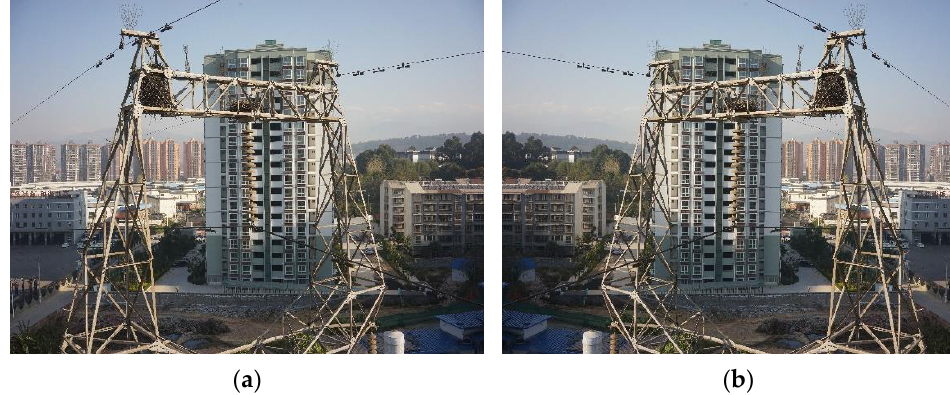
Figure 6. ( a ) Original image; ( b ) horizontal flip.